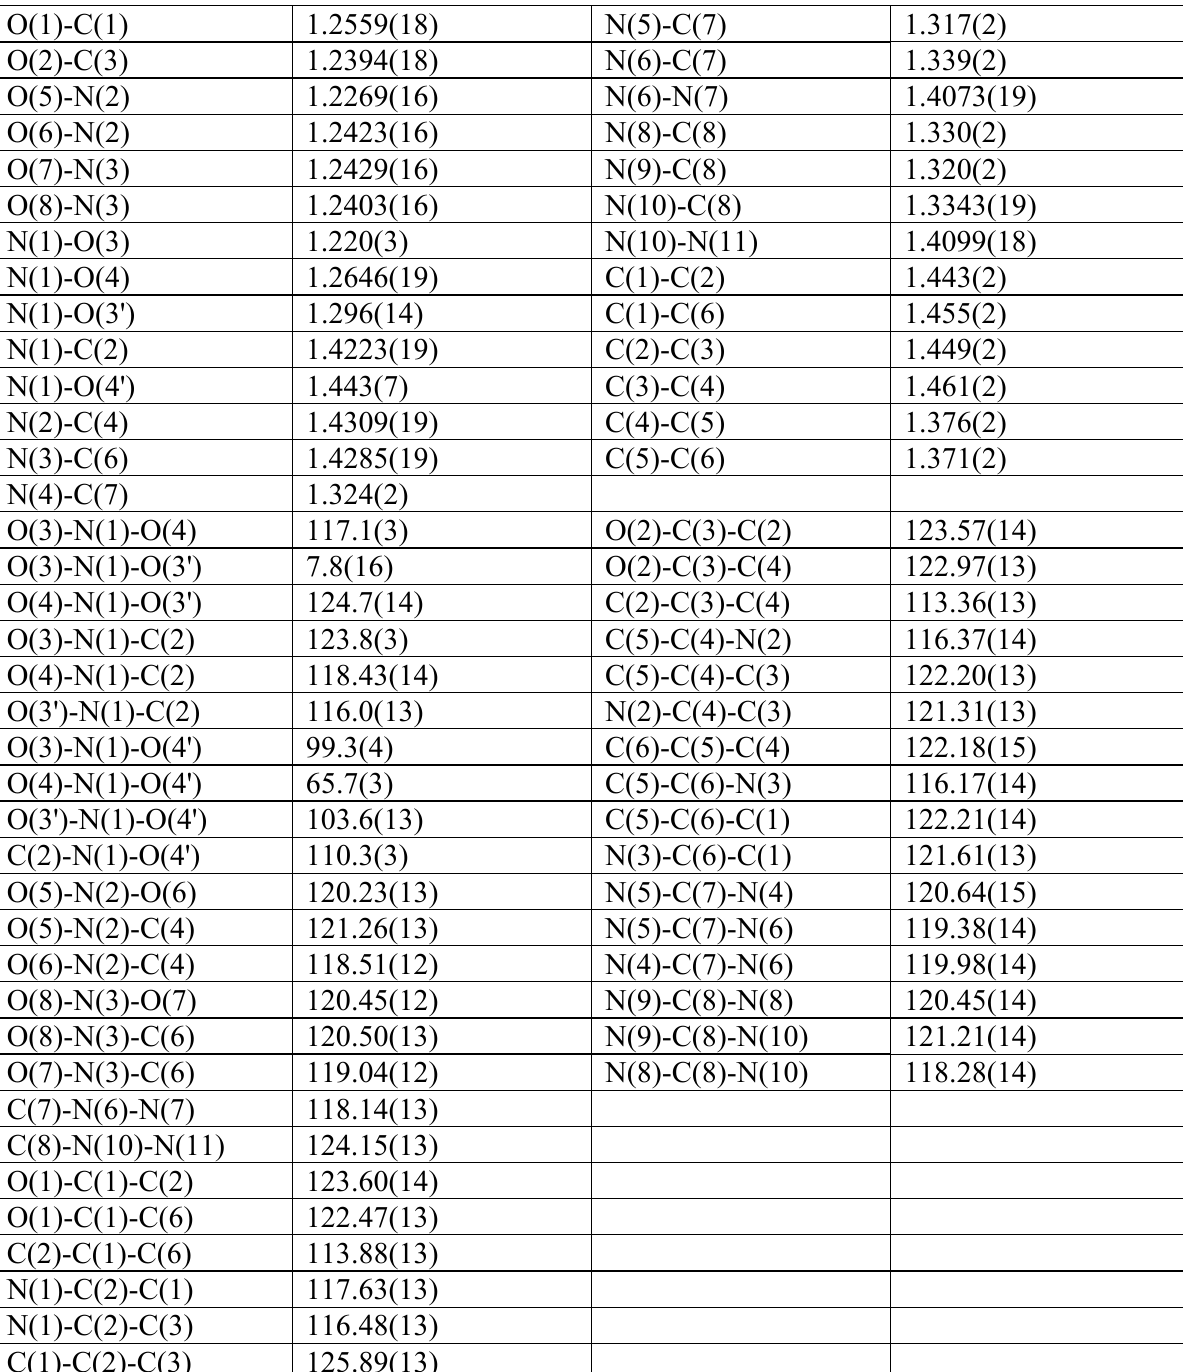
Table 2. Selected bond lengths [Å] and angles [°] for aminoguanidinium